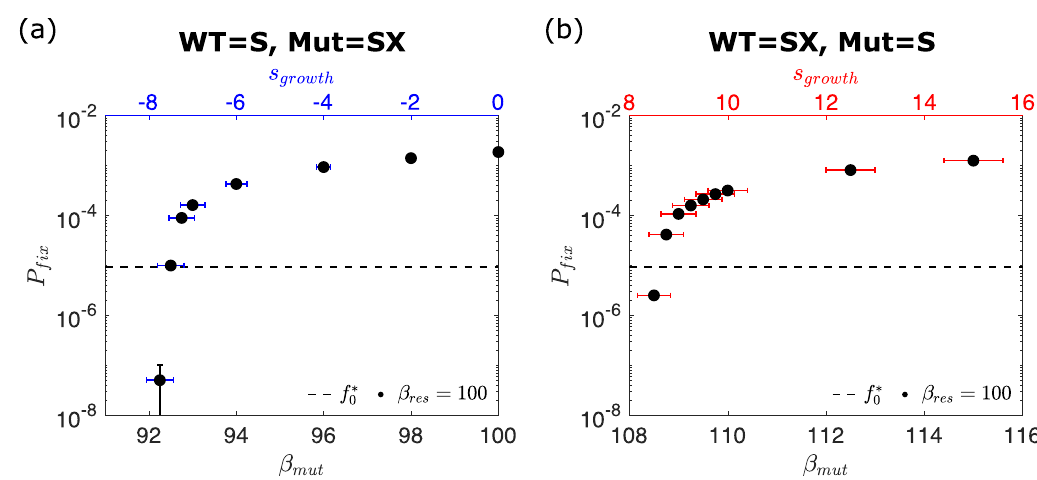
Fig 6. Mutations which alter the ability to prevent superinfection. (a) The probability P fix of a mutant which prevents superinfection fixing in a population that allows it, as a function of mutant burst size β mut . (b) The probability P fix of a mutant which allows superinfection fixing in a population that prevents it, as a function of mutant burst size β superinfecting mutant requires a significantly increased burst size to fix, and conversely the superinfection-excluding mutant can fix, even if its burst size is greatly reduced. The error in our estimate of the fixation probability Δ P where n and n represent the total number of simulations and the number of simulations where the mutant fixes respectively. fix Error bars in the x -axis represent the errors on the growth rate fitness s growth that each burst size corresponds to. These are calculated by fitting a linear relation to growth rate measurements such that s s growth is then equal to the fractional error on the fitted gradient m . The fixation data is obtained from a minimum of 20 million independent